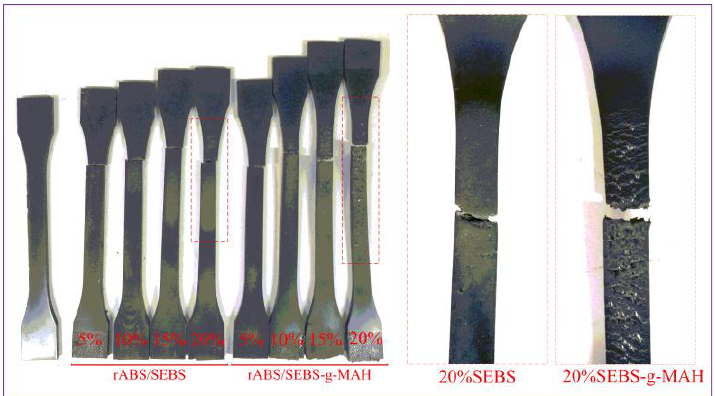
Figure 3. Photo of tensile sample.